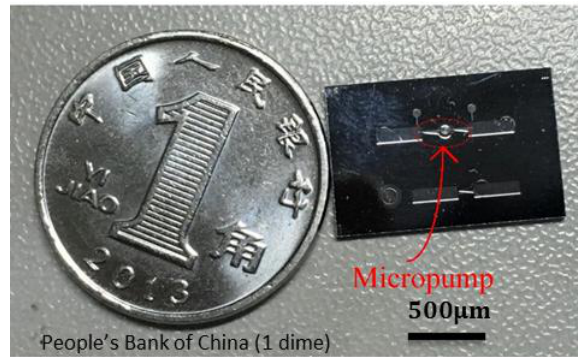
Figure 5. Micro-pump compared with a coin.